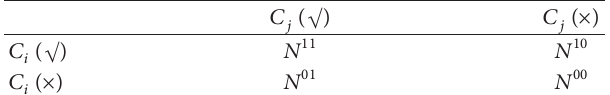
Table 1: Confusion matrix for two classifiers. ( √ ) denotes the correct prediction given by the classifier and ( × ) denotes incorrect